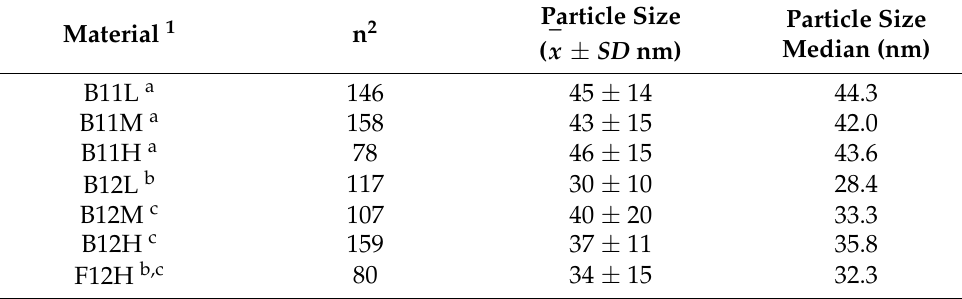
Table 2. Measurement of particle size using TEM